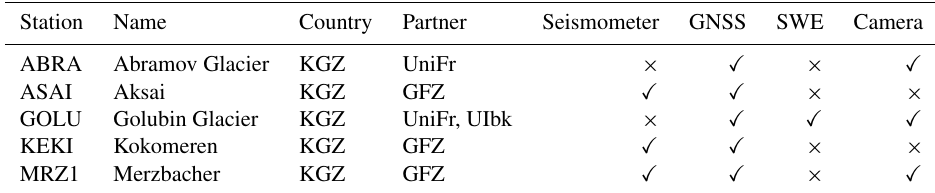
Table 3. Station list with additionally installed sensors. The column “Partner” in this table does not refer to the institute that is operating the station but to the owner of the additionally installed sensor.